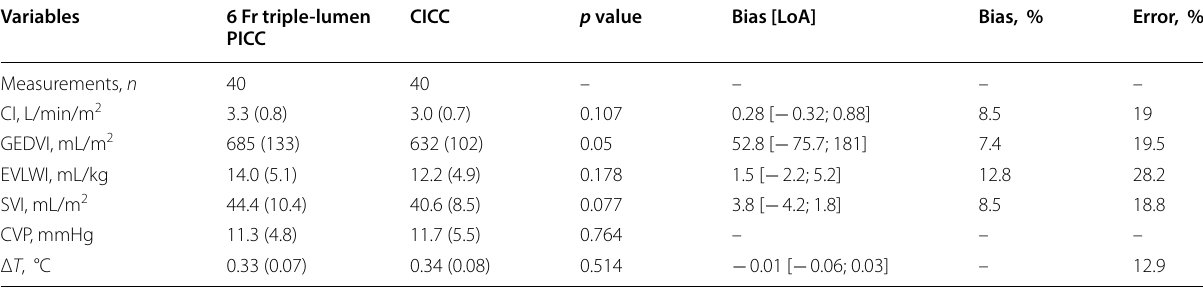
Data are reported as mean (standard deviation) CI: cardiac index; CICC: centrally inserted central catheter; CVP: central venous pressure; EVLWI: extra-vascular lung water index; GEDVI: global end-diastolic volume index; LoA: limits of agreement; PICC: peripherally inserted central catheter; SVI: stroke volume index; Δ T : delta temperature